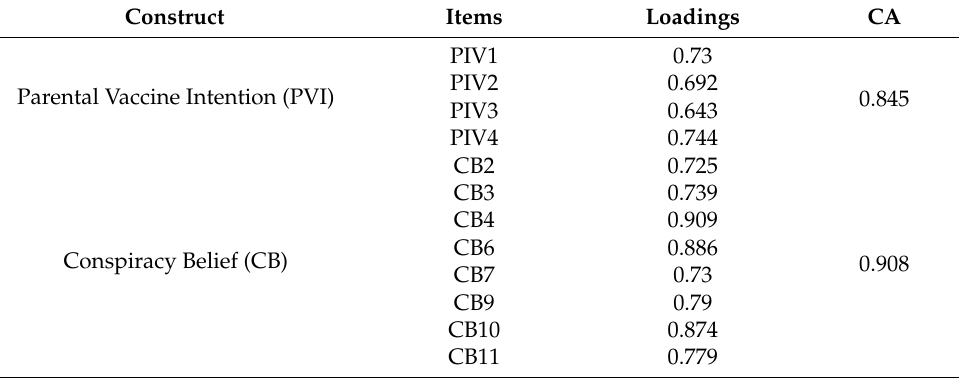
Table 2. Factor loadings and Cornbach